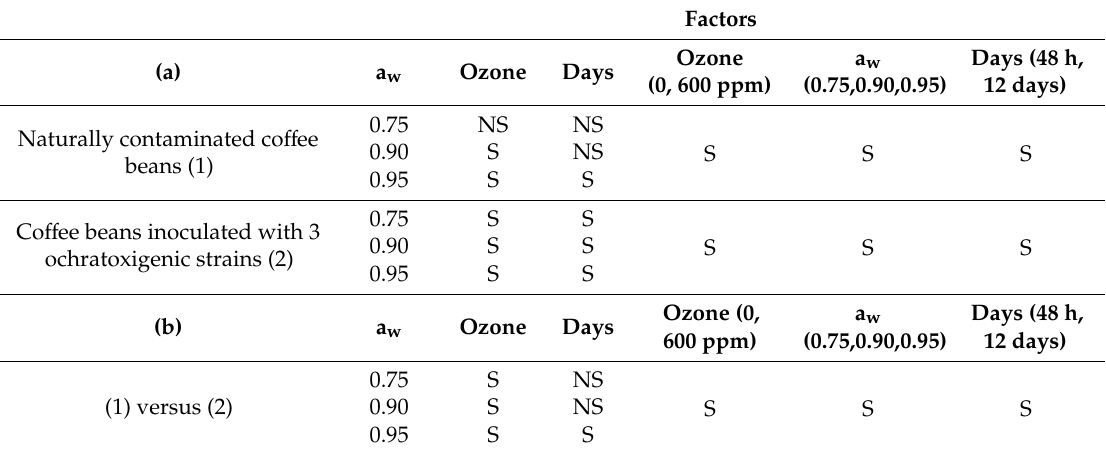
Table 3. The statistical results for control of fungal populations (log 10 + 1 CFUs g − 1 dry weight) on (a) naturally contaminated co ff ee beans and that inoculated with the three ochratoxigenic strains, and (b) compares naturally contaminated co ff ee beans and those contaminated with the 3 strains by using Kruskal–Wallis Test * (non-normality